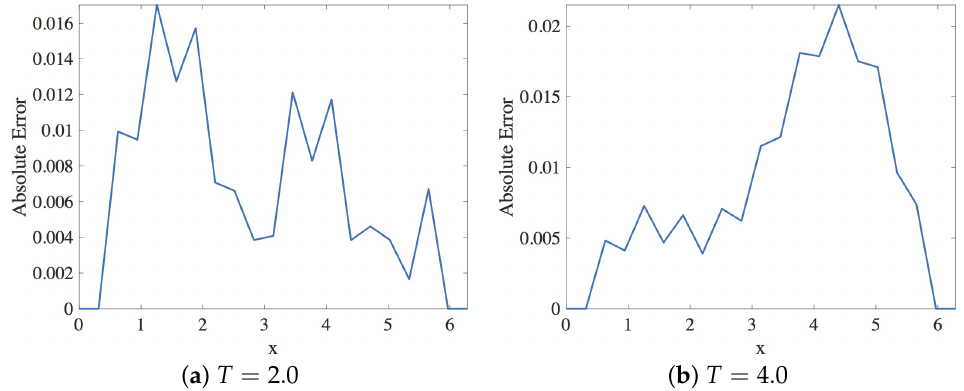
Figure 3. Plot of exact and numerical profiles (using Scheme 1), vs. x at times 2.0 and 4.0 using h = π /10 and k = 0.001 (Numerical Experiment 1).